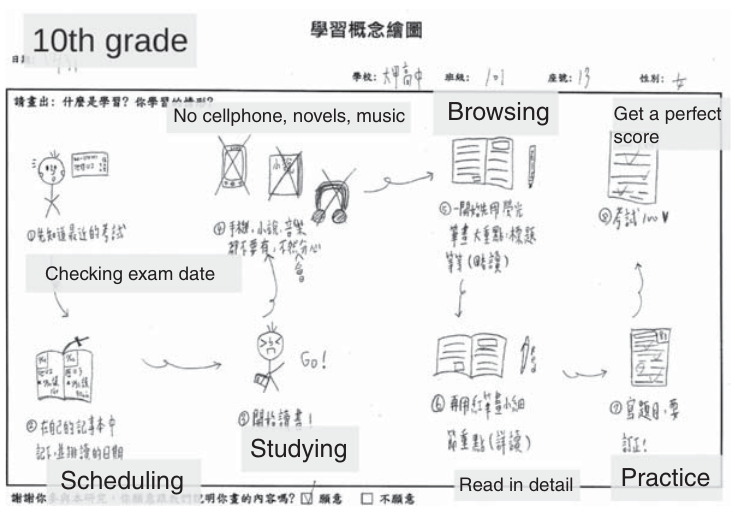
Figure 15. A drawing by a 6th grade student showing a demolish figure with the word “ English ” on its forehead haunting him